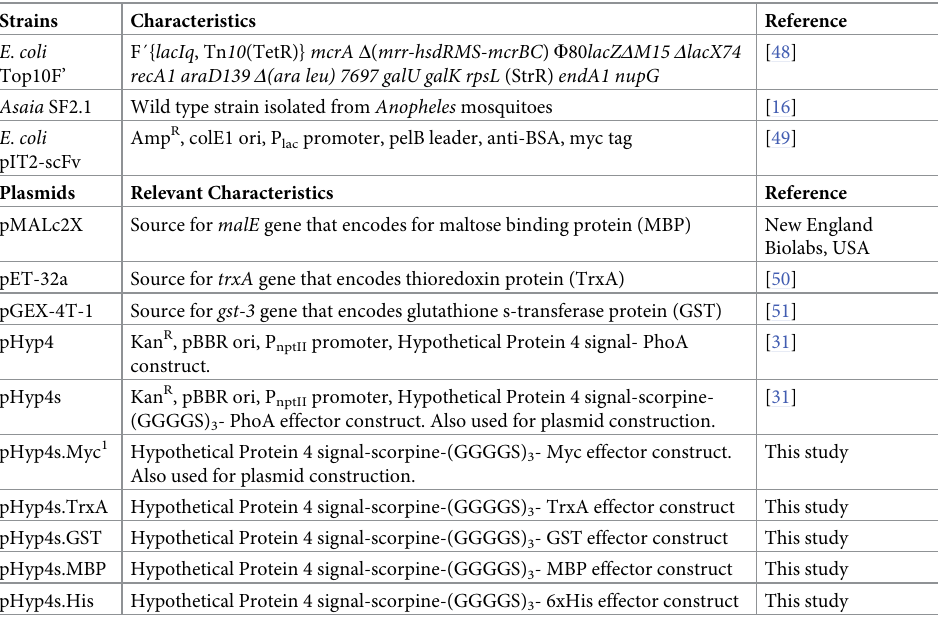
Table 1. Strains and plasmids used in this